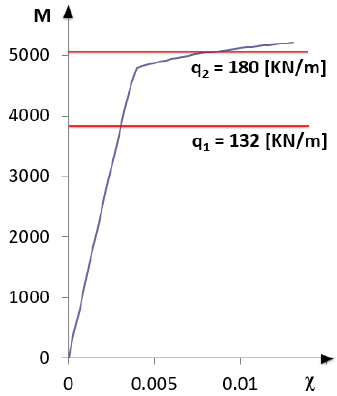
Figure 3. Bending moment-curvature diagram with load level.